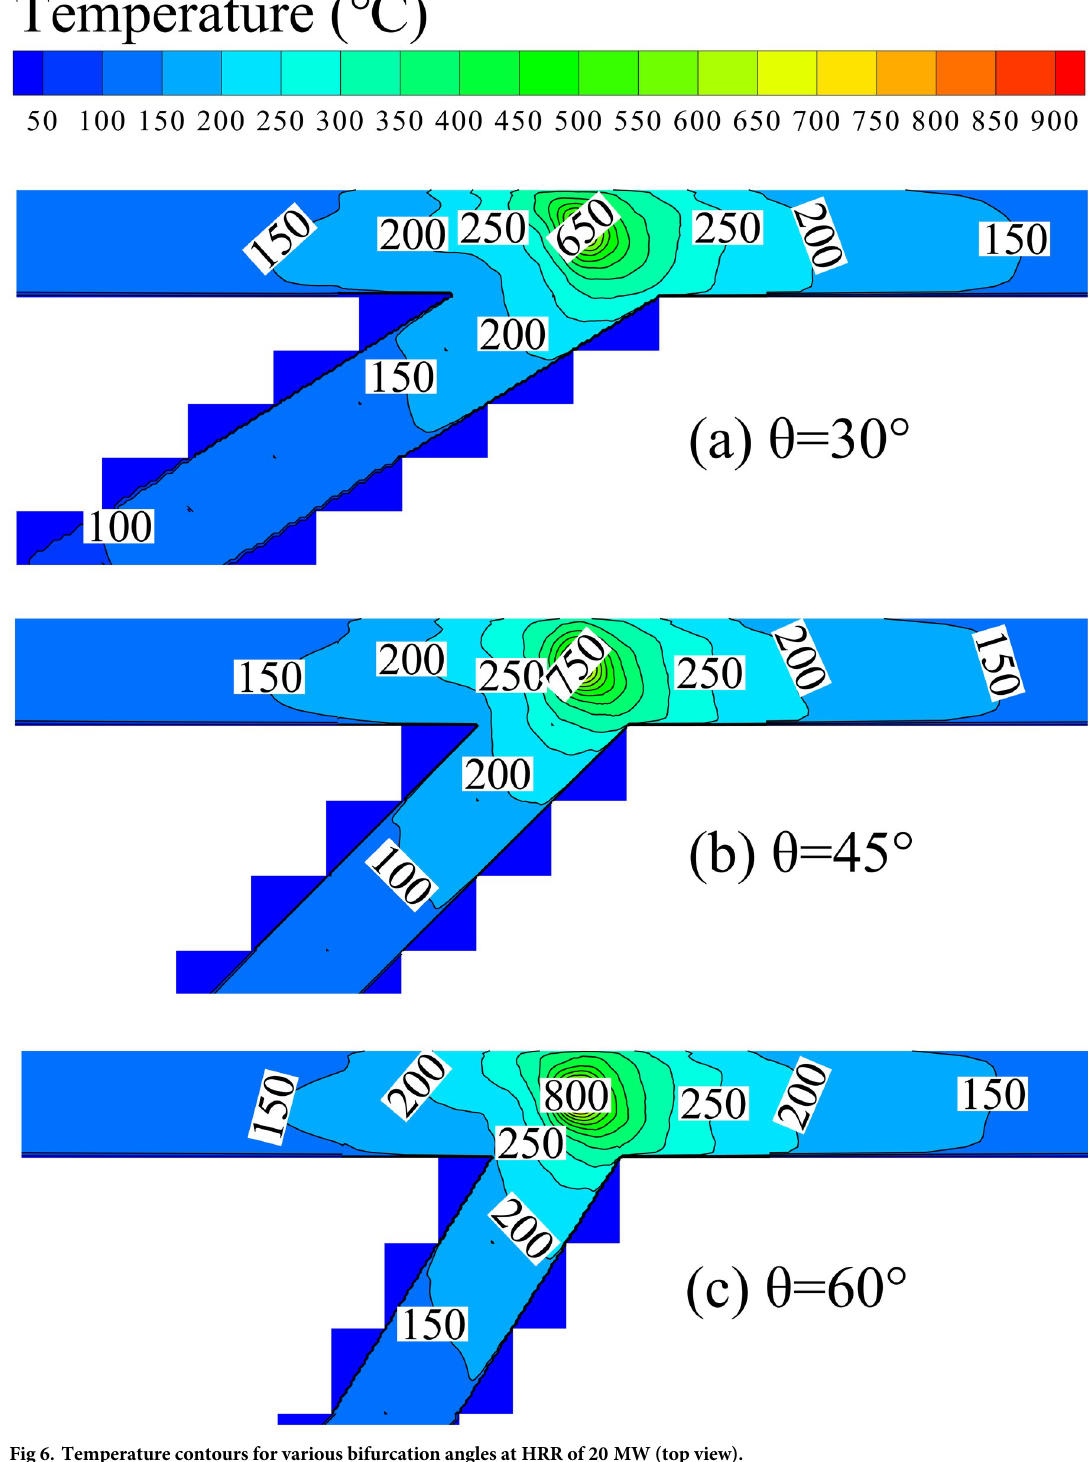
PLOS ONE | https://doi.org/10.1371/journal.pone.0262546 January 10,